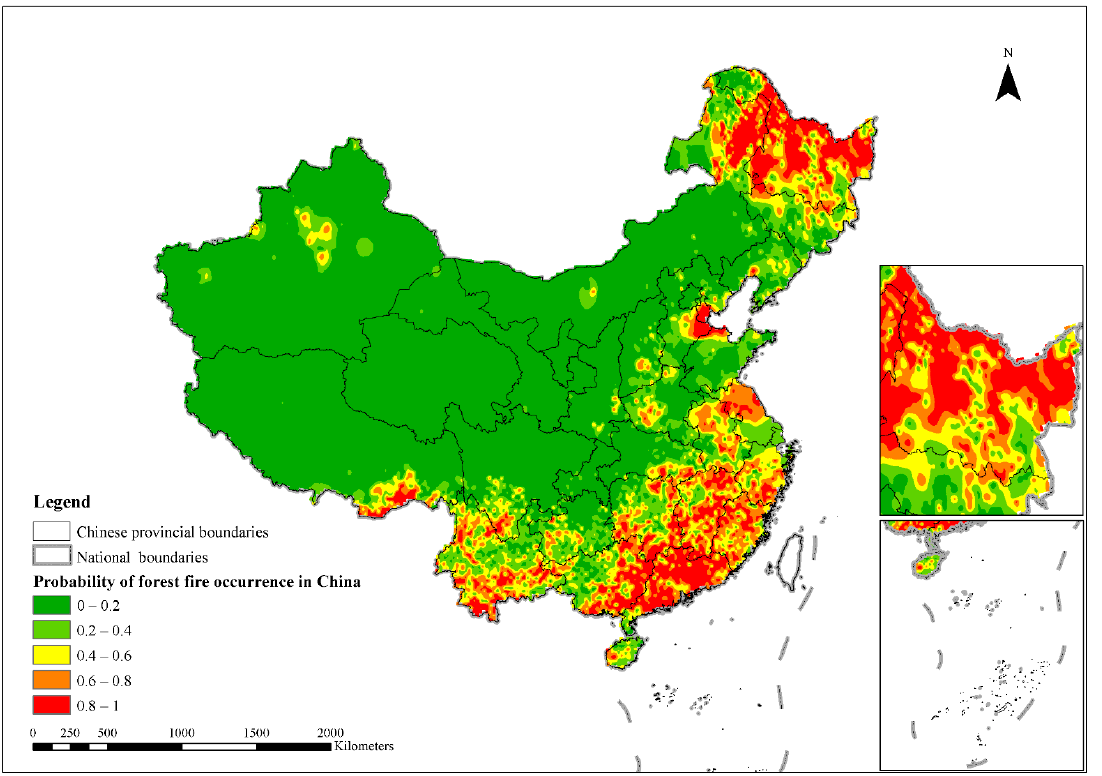
Figure 12. Forest fire probability map for China based on the RF model.